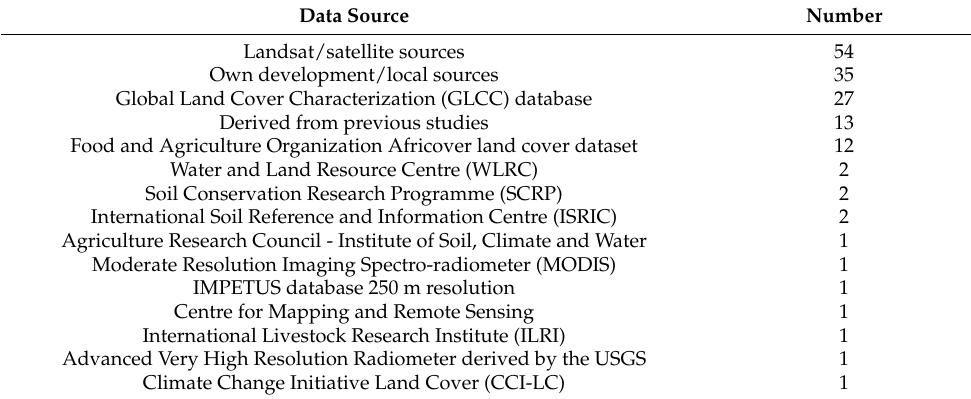
Table A1. Land use data